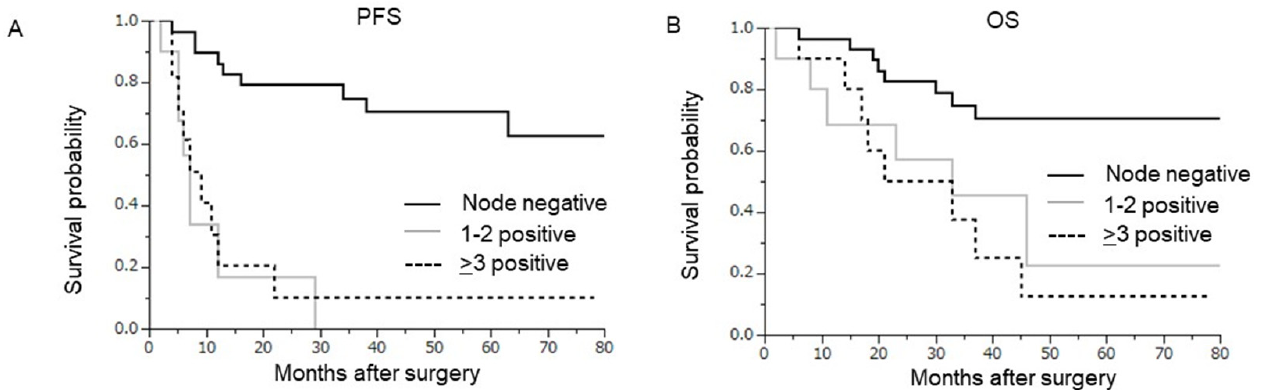
Figure 2. Prognostic significance of the number of lymph node metastases in node-positive patients. Kaplan–Meier estimates of survival according to the number of lymph nodes (1–2 ( n = 10) versus ≥ 3 ( n = 11)). Survival rates of the node-negative group ( n = 29) are also provided as references. ( A ) Progression-free survival (1–2 versus ≥ 3, p = 0.7736). ( B ) Overall survival (1–2 versus ≥ 3, p = 0.5229).